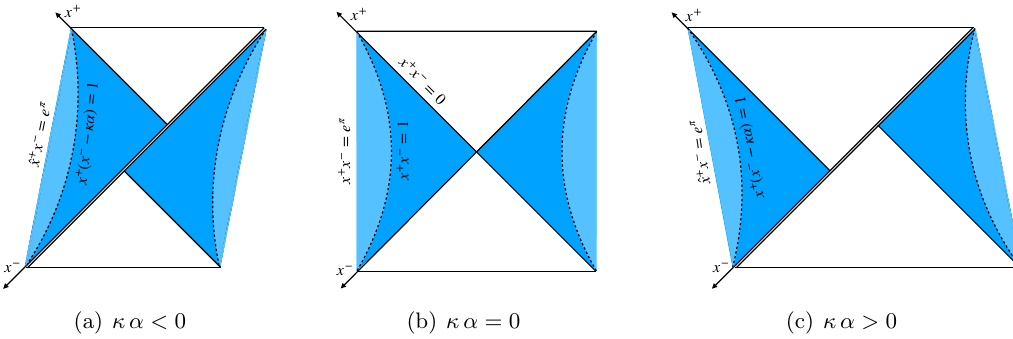
Figure 5 . Penrose diagrams for interpolating geometries after a shockwave